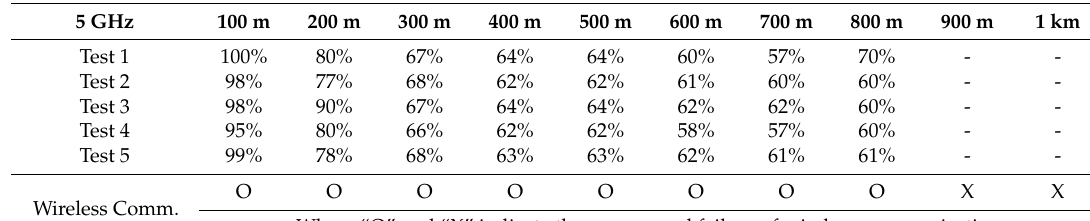
Table 2. Wireless communication distance and receive sensitivity at WiFi 5